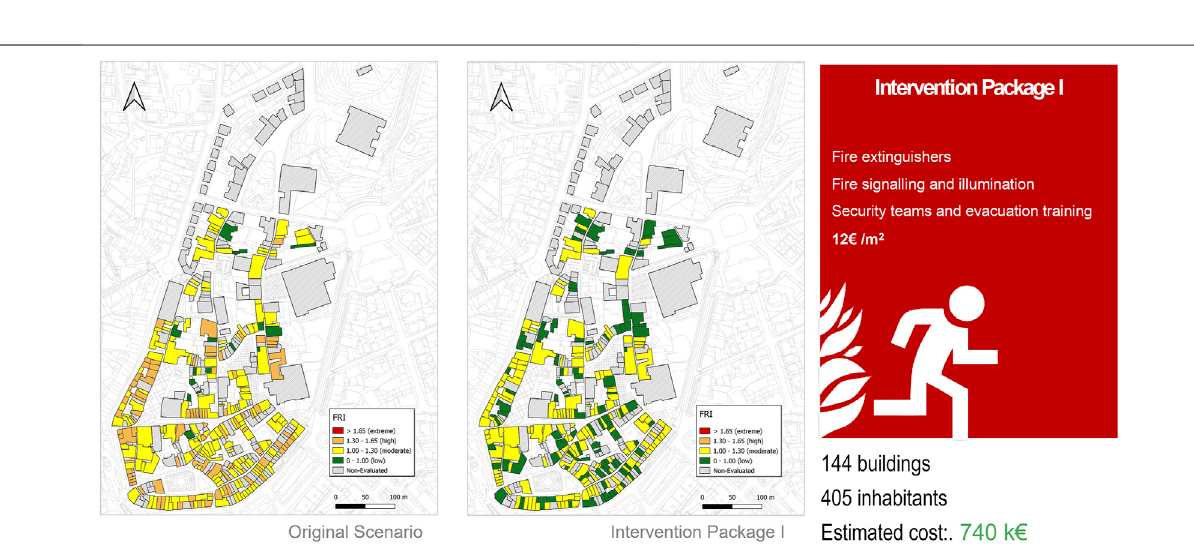
Frontiers in Earth Science |